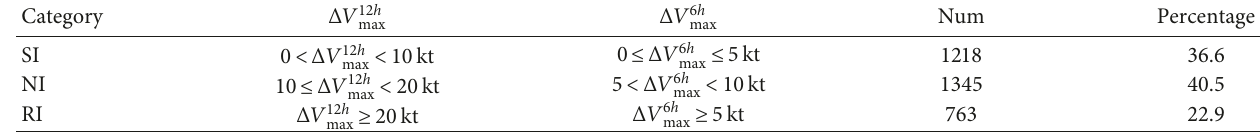
Table 1: Definitions and sample sizes of the three intensification